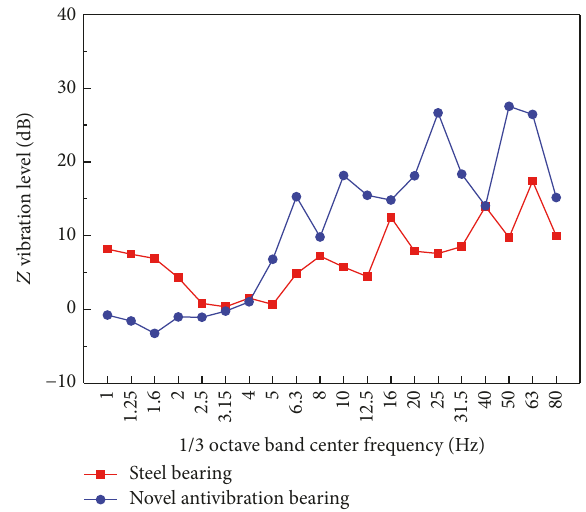
Figure 18: Comparison of the insertion loss for steel bearing and novel antivibration